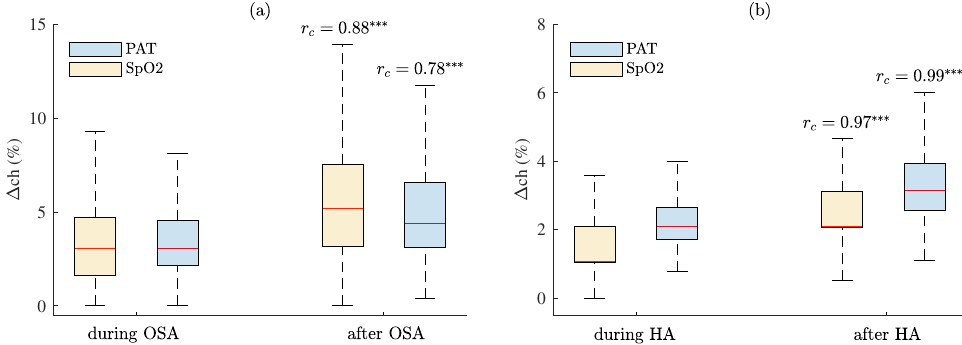
Figure 13. The percentage changes of PAT and SpO2 during and 30 s after ( a ) OSA and ( b ) hypopnea episodes across all subjects with estimated matched-pairs r c values. p < 0.001 and r c ≥ 0.50 is marked ∗∗∗